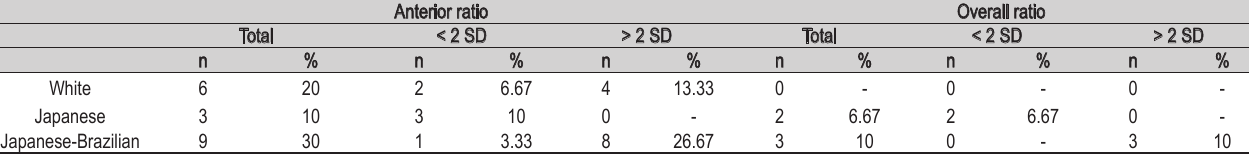
Table 3 - Number and percentage of subjects outside Bolton standards ± 2 SD.